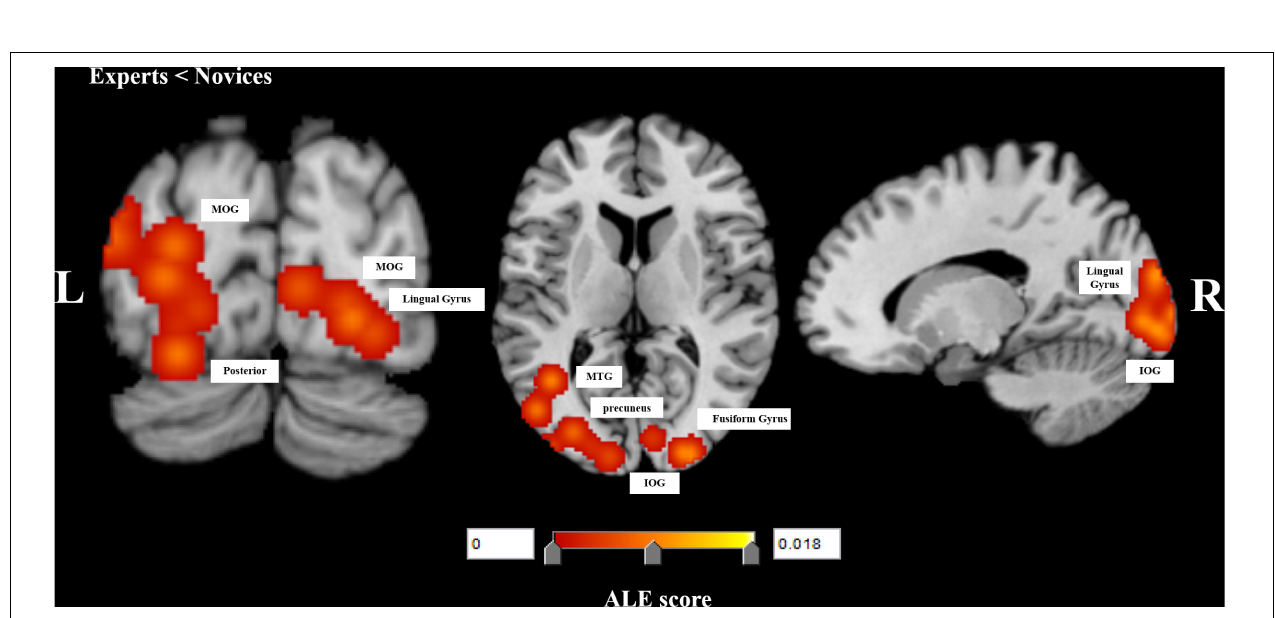
FIGURE 3 | Significant meta-analysis results for comparison between experts and novices performing decision-making tasks. L, left, R, right, middle temporal gyrus, MTG, middle occipital gyrus, MOG, inferior occipital gyrus, IOG.